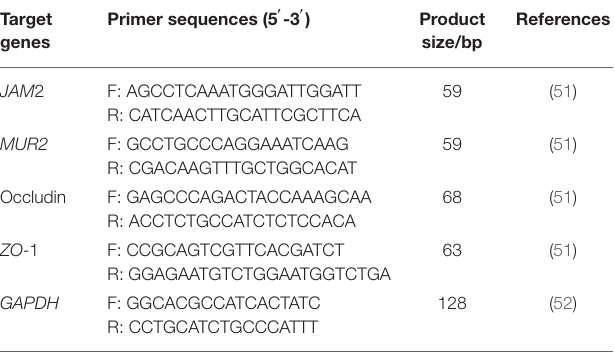
TABLE 3 | Primers used for real-time PCR analysis. Target genes